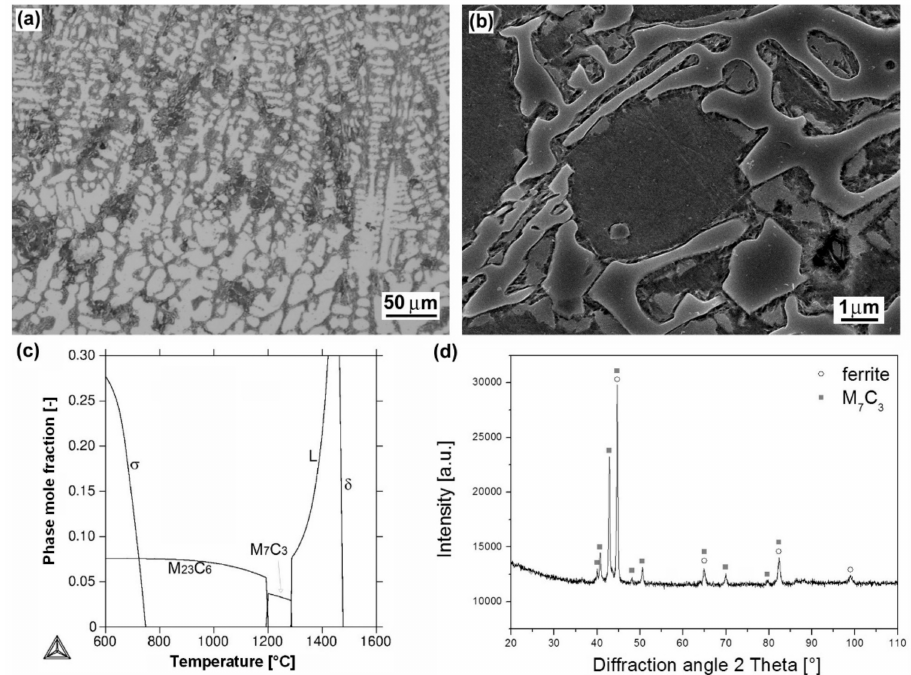
Figure 2. Characterization of “E520 RB” hardfacing: overall microstructure visualized by light-optical microscope (LOM) ( a ); detailed microstructure visualized by scanning electron microscope (SEM) ( b ); thermodynamic calculation of equilibrium phase composition depending on temperature ( c ); X-ray di ff raction (XRD) pattern representing experimentally determined phase composition ( d